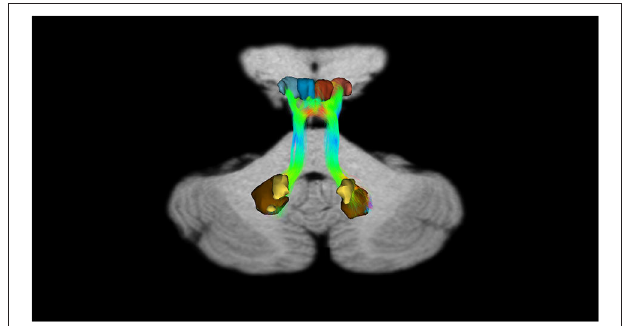
FIGURE 8 | Dentate-SN and dentate-VTA interconnections. Coronal view shows the interconnections between the right dentate nucleus and left dentate nucleus to the ipsilateral SN, between the right dentate nucleus and left dentate nucleus to the ipsilateral and contralateral VTA. The fibers exited the cerebellum via the right and left superior cerebellar